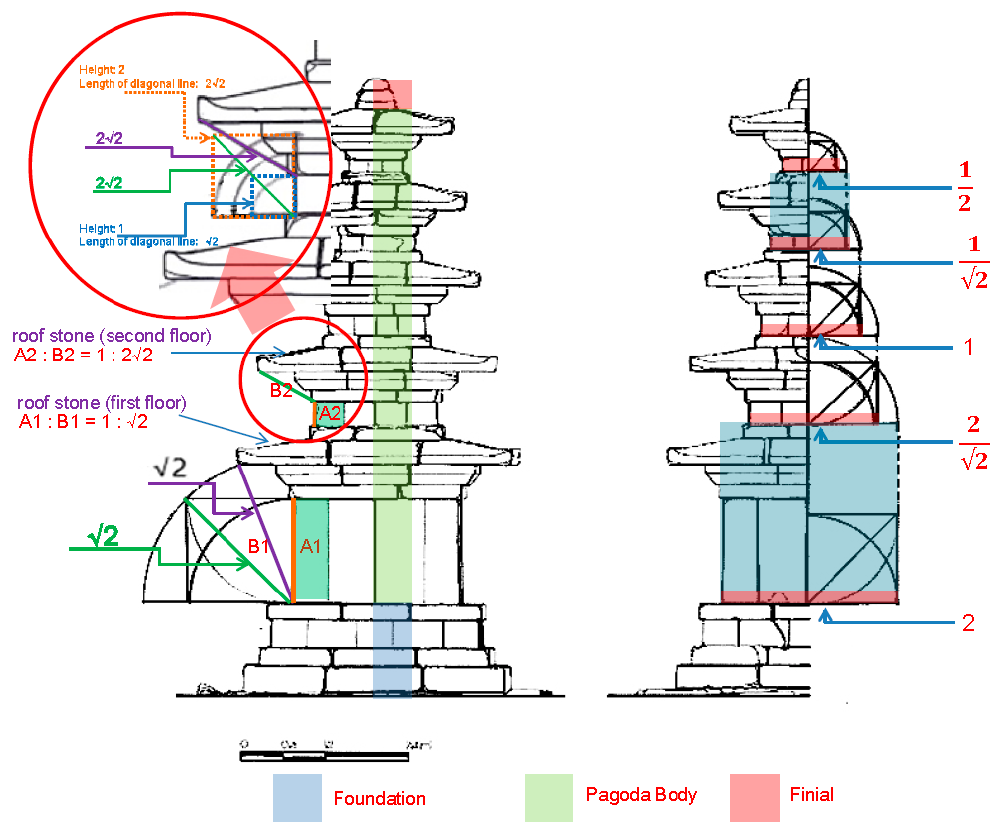
Figure 6. Proportional analysis of the five-story pagoda at Ch ŏ ngnimsa Temple.